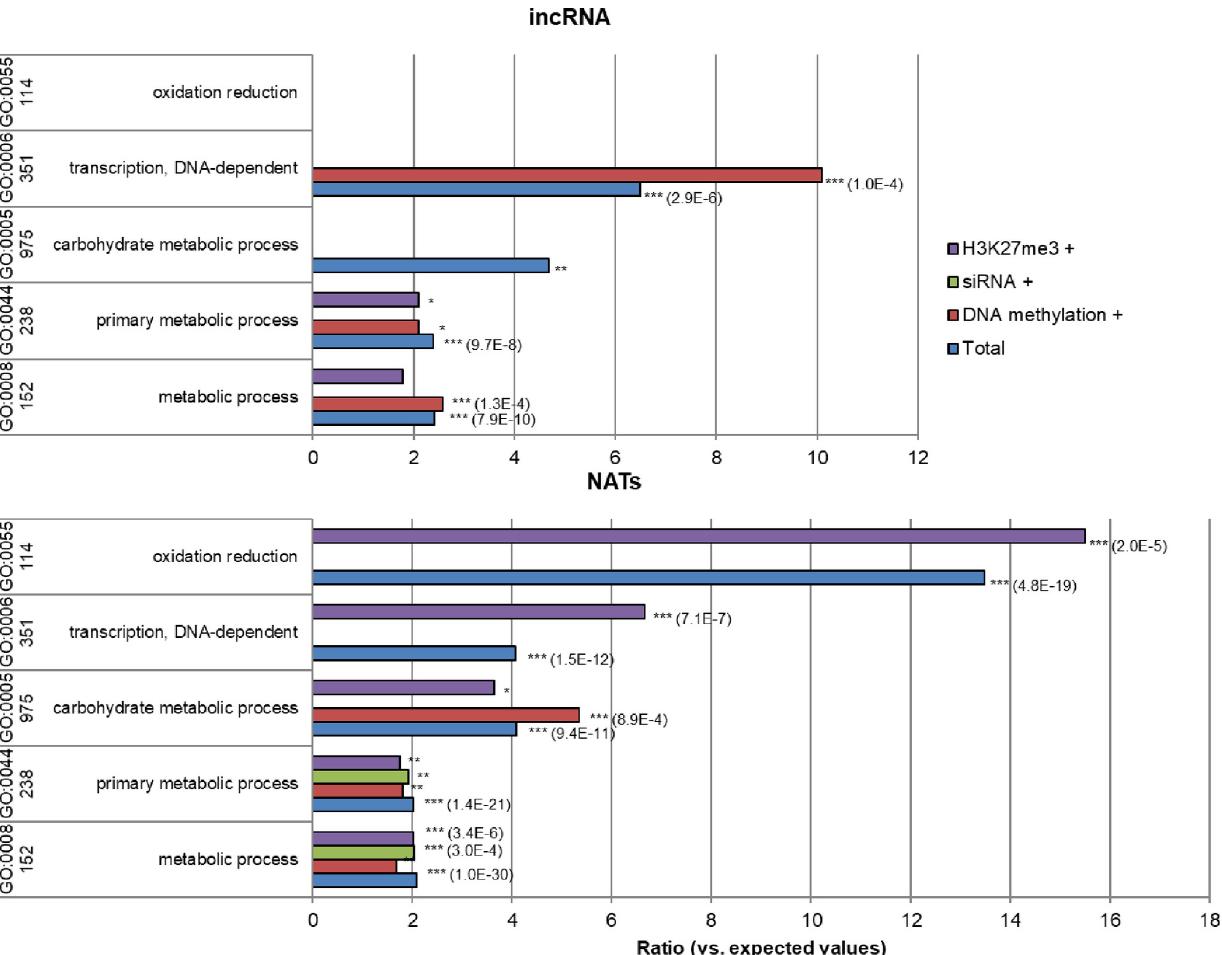
Fig 6. GO analysis of incRNA and NATs and different epigenetic marks (DNA methylation, siRNA, H3K27me3). � , p < 0.05; �� , p < 0.01; ��� , p < 0.001. Overrepresentation of the identified paired genes between incRNA or NATs to DNA methylation, siRNAs or H3K27me3 loci for each GO category is